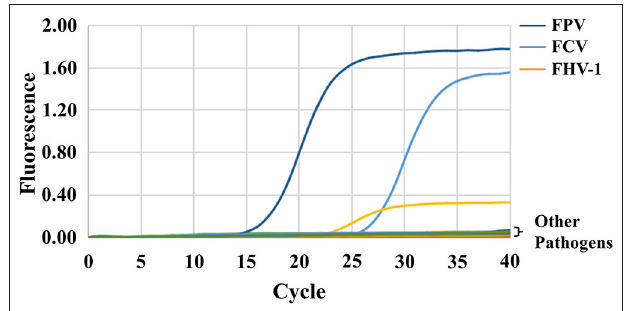
FIGURE 2 | Specificity of the triplex assay. FPV, FCV, FHV-1, and other animal pathogens (including FIV, FeLV, FCoV, RV, and PRV) were selected and tested using the triplex assay. Only FCV, FHV-1, and FPV detected positive.